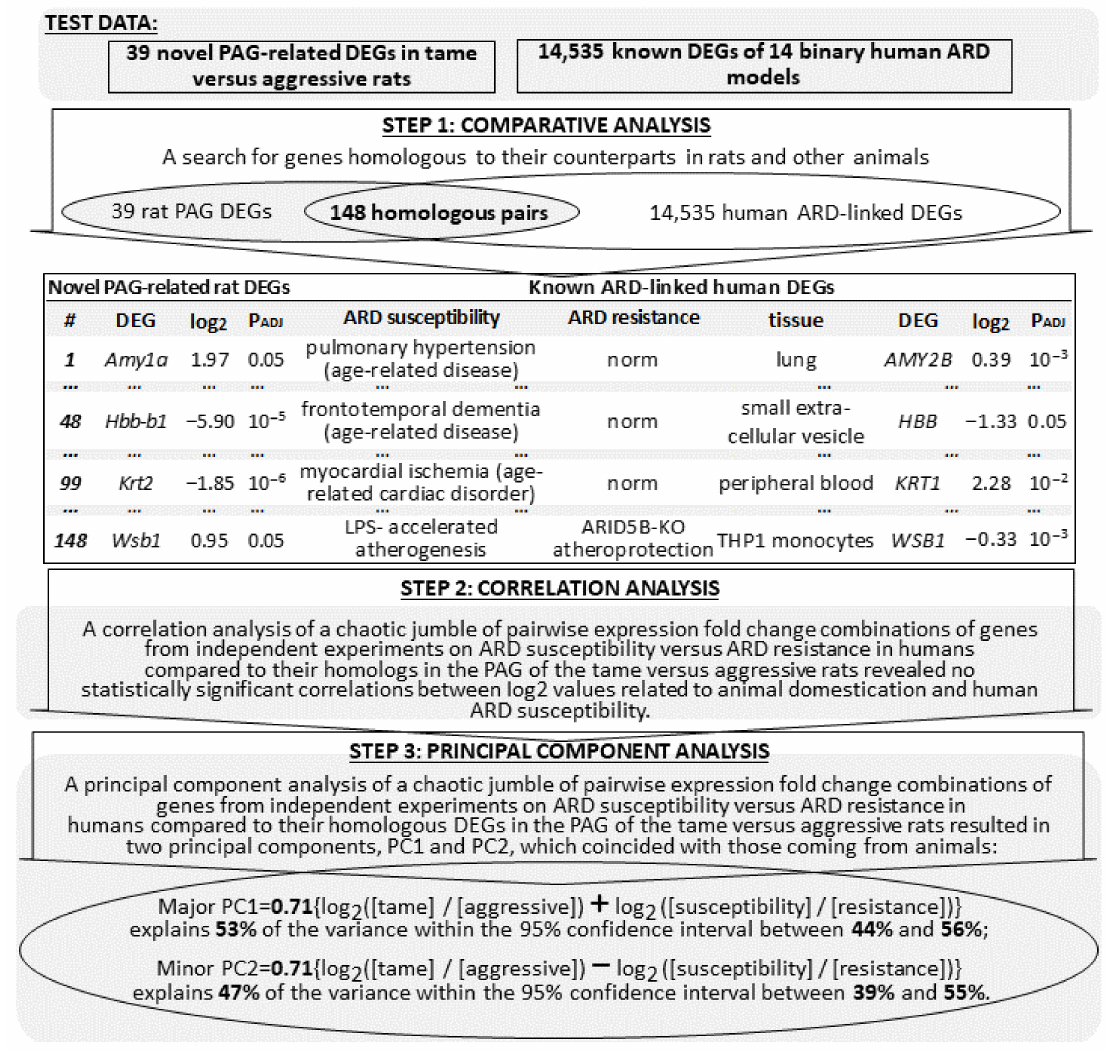
Figure 3. Animal ARD-linked DEGs are relevant to humans. Legend: See the legend to Figure 2 and the footnote to Table